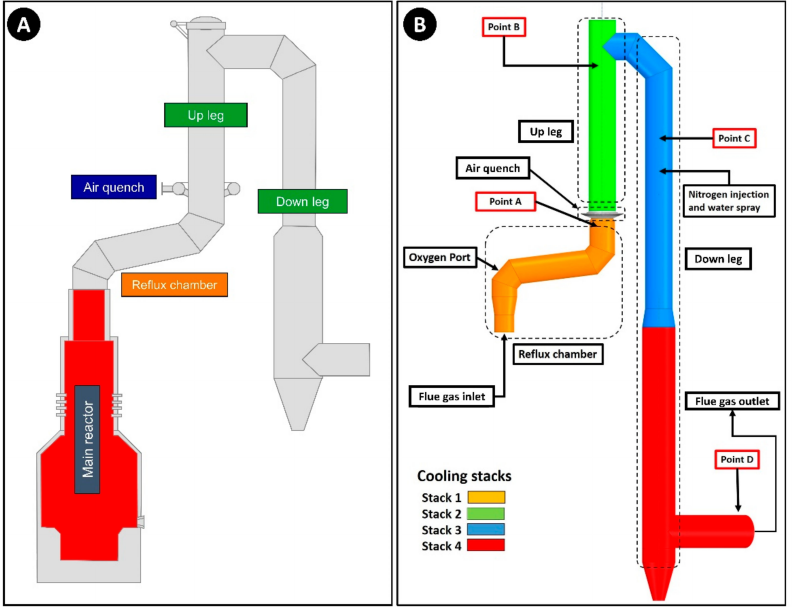
Figure 2. A: Schematic representation of HIsarna main components; main reactor and off-gas system ( A ); off-gas system with plant measurement points ( B ) (Point A: reflux chamber outlet, Point B: end of up leg, Point C: 3 m above water quench atomizers, Point D: exit to gas